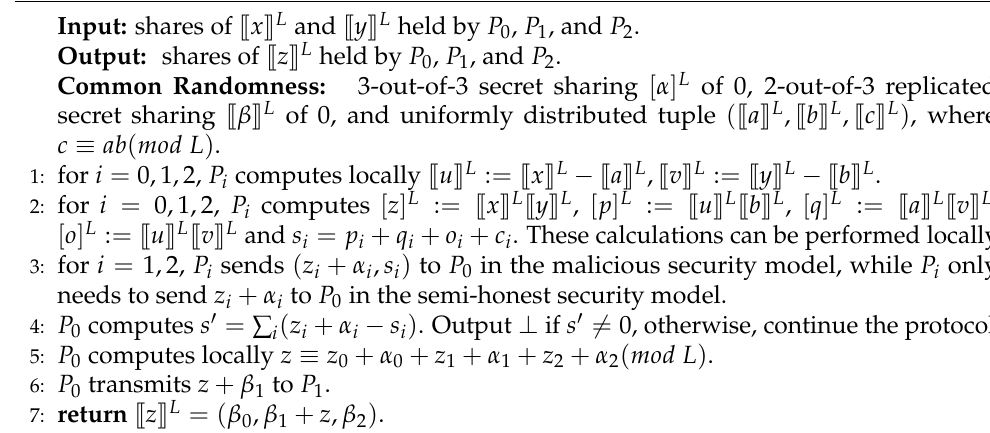
Algorithm 1 Multiplication protocol ∏